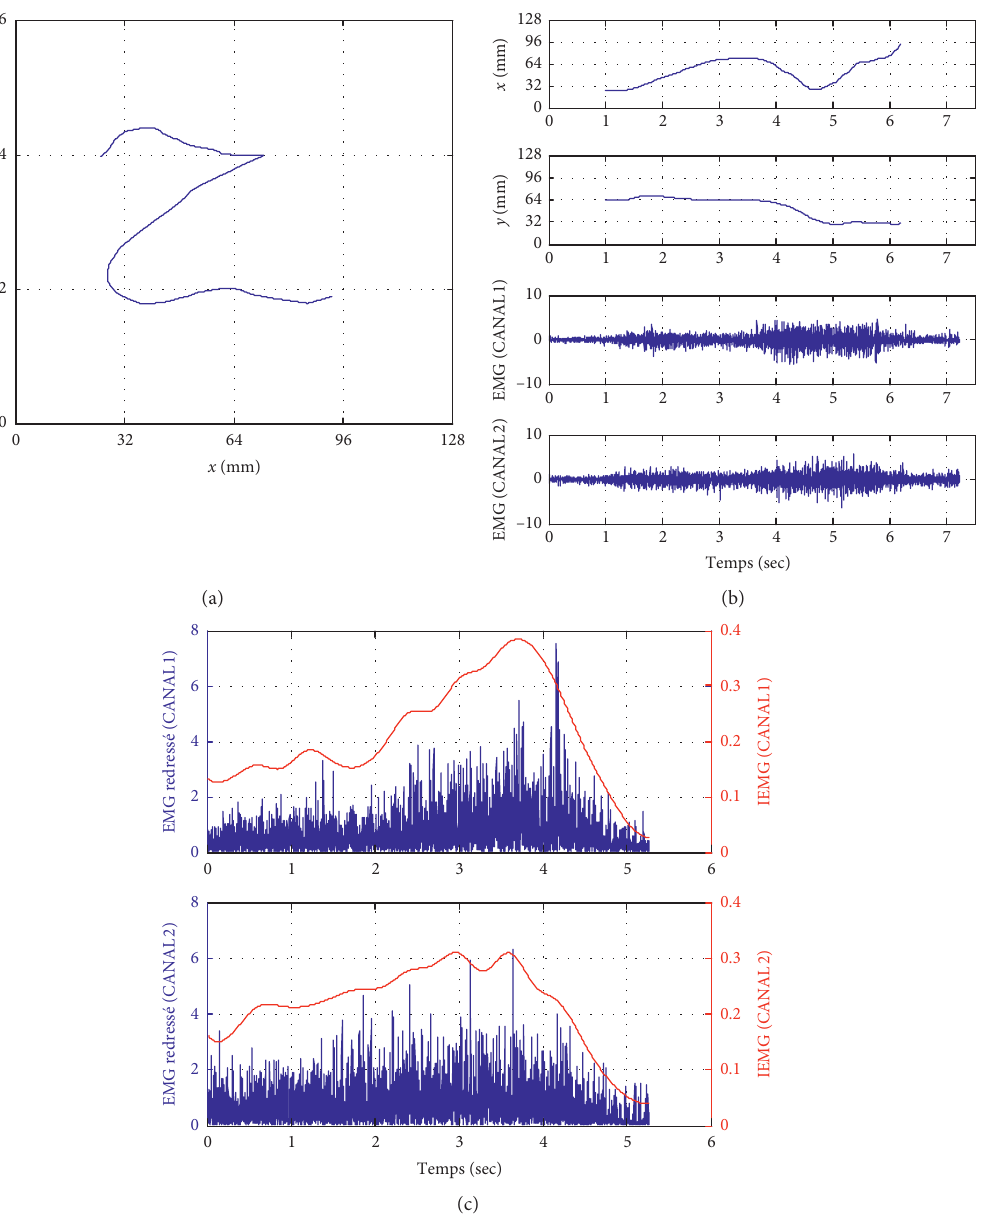
Figure 2: Example of experimental recordings. (a) Arabic letter “HA.” (b) Displacement accordingto x -and y -axis EMG signals. (c) IEMG signals.